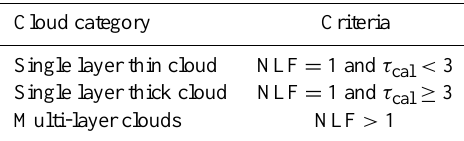
Table 8. Definition of three cloud categories investigated in Sect. 4.2. Single and multi-layer clouds are separated by the CALIOP product Number of Layers Found (NLF). Single layer clouds are further subdivided into optically thin and thick clouds using the CALIOP column cloud optical depth at 532nm τ cal